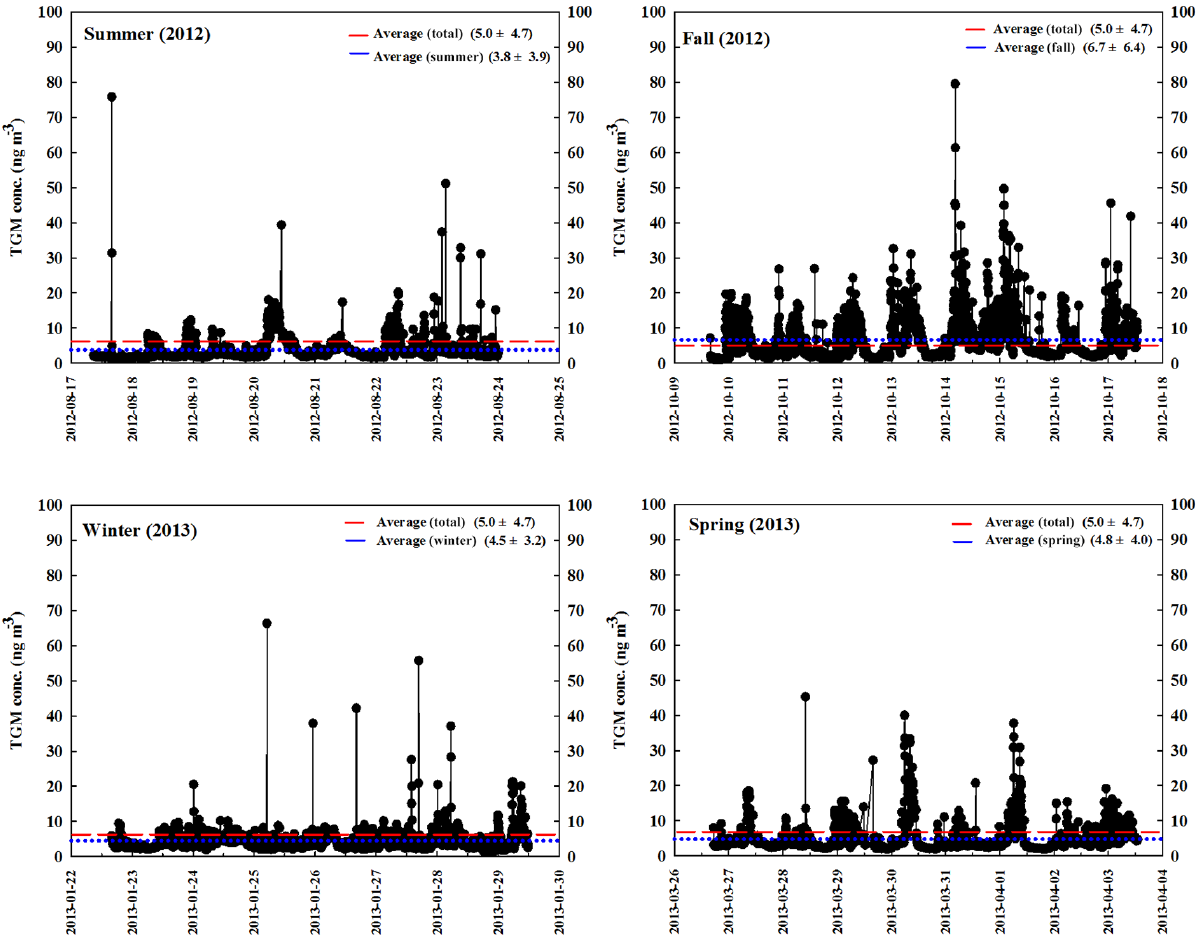
Figure 2. Time series of TGM concentrations in this